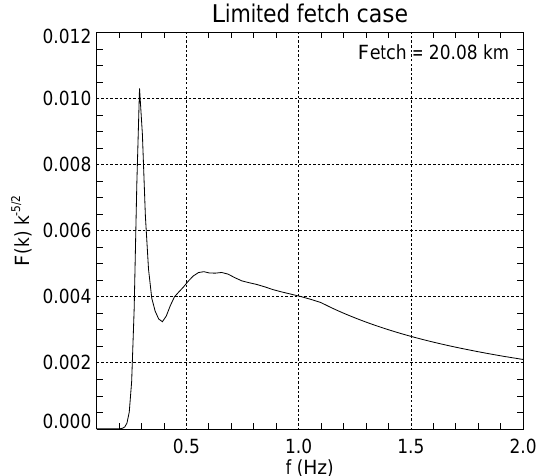
Figure 22. Experimental, theoretical and numerical evidence of the c p ) 1 / 3 /g 1 / 2 . Dashed line – theoretical dependence of 1000 β on (u 2 λ prediction Eq. (10) for λ = 2 . 11; dotted line – experimental regres- sion line from Resio et al. (2004) and Long and Resio (2007). Line connected diamonds – the results of numerical calculations for the wind speed U = 10ms − 1 limited fetch case. Being parameterized by the dimensionless fetch coordinate χ = xg , the numerical sim- U 2 ulation trajectory evolves from the left to the right on the graph, covering a fetch span from χ = 0 . to χ (cid:39) 3 . 0 × 10 4